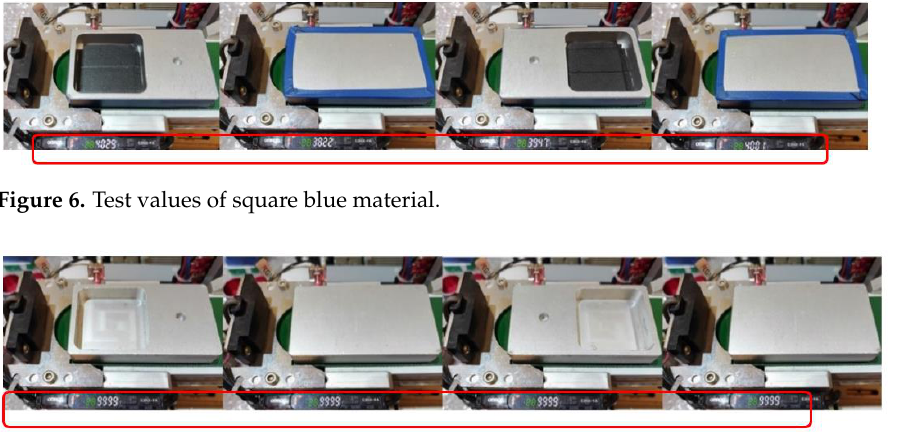
Figure 7. Test values of square gray material.